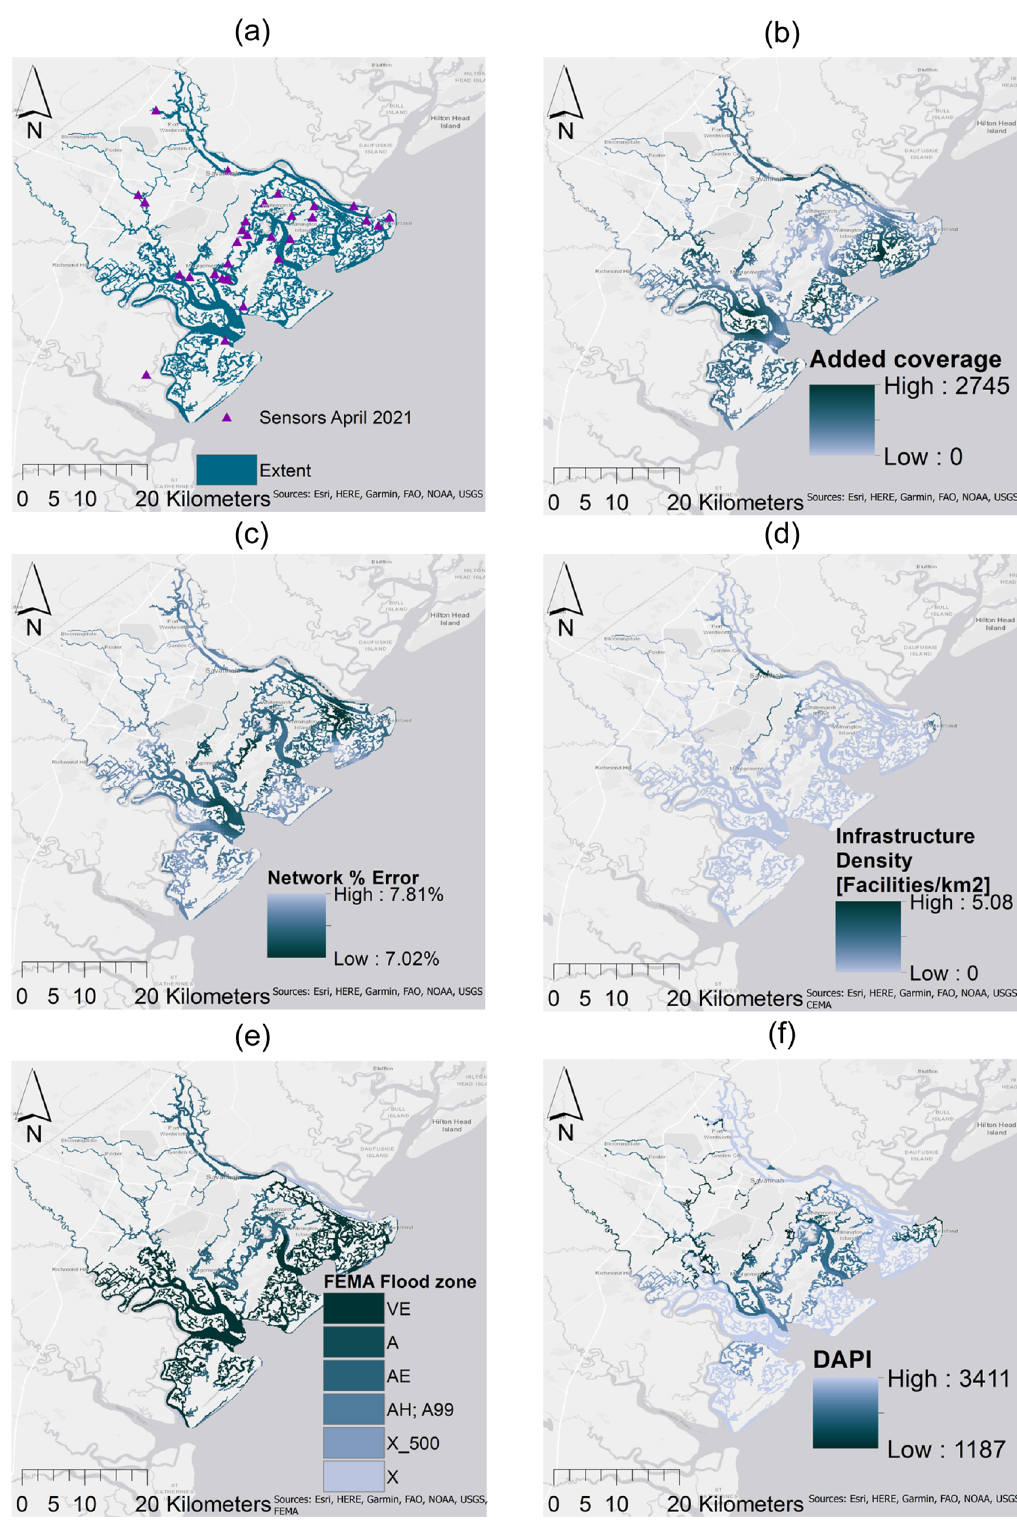
Fig. 2 Sensor network parameters calculated for all possible solution locations. a Extent of the solution space covering a full set of feasible solutions. b Network coverage over the extent. c Network uncertainty over the extent. d Critical infrastructure facilities density as measured using a kernel density. e Flood zone over the extent. f Social vulnerability ranking as measured by the Damage Assessment Priority Index